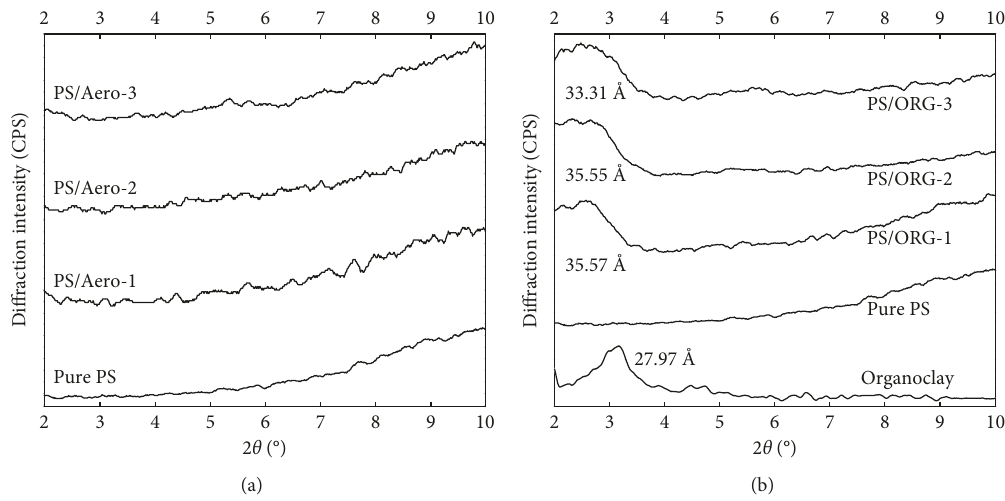
Figure 6: XRD patterns of PS/clay nanocomposites prepared from the nanoclay aerogel masterbatch and